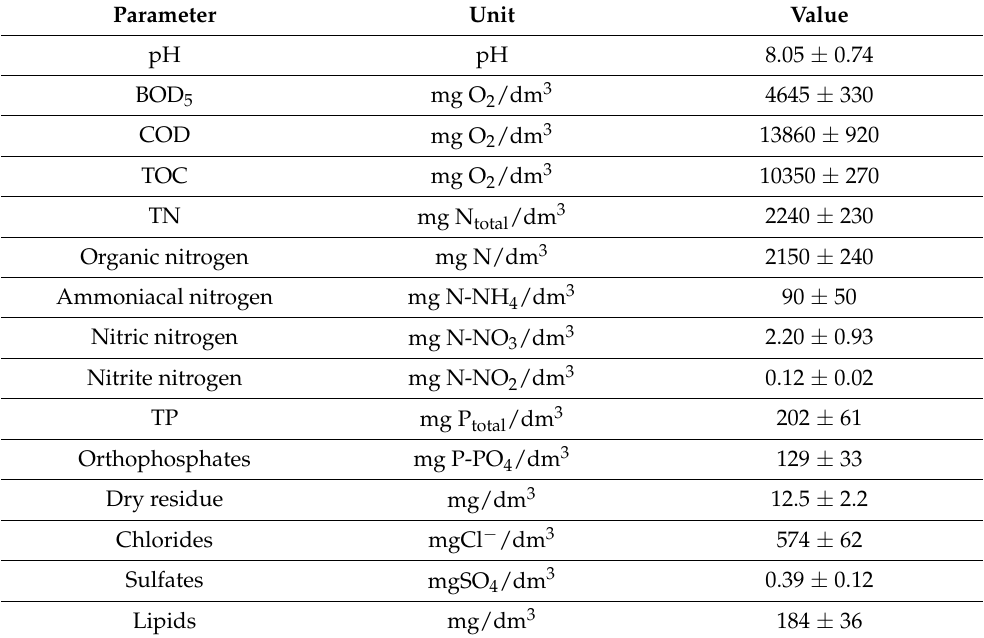
Table 2. Profile of the chemical toilet sewage used in the